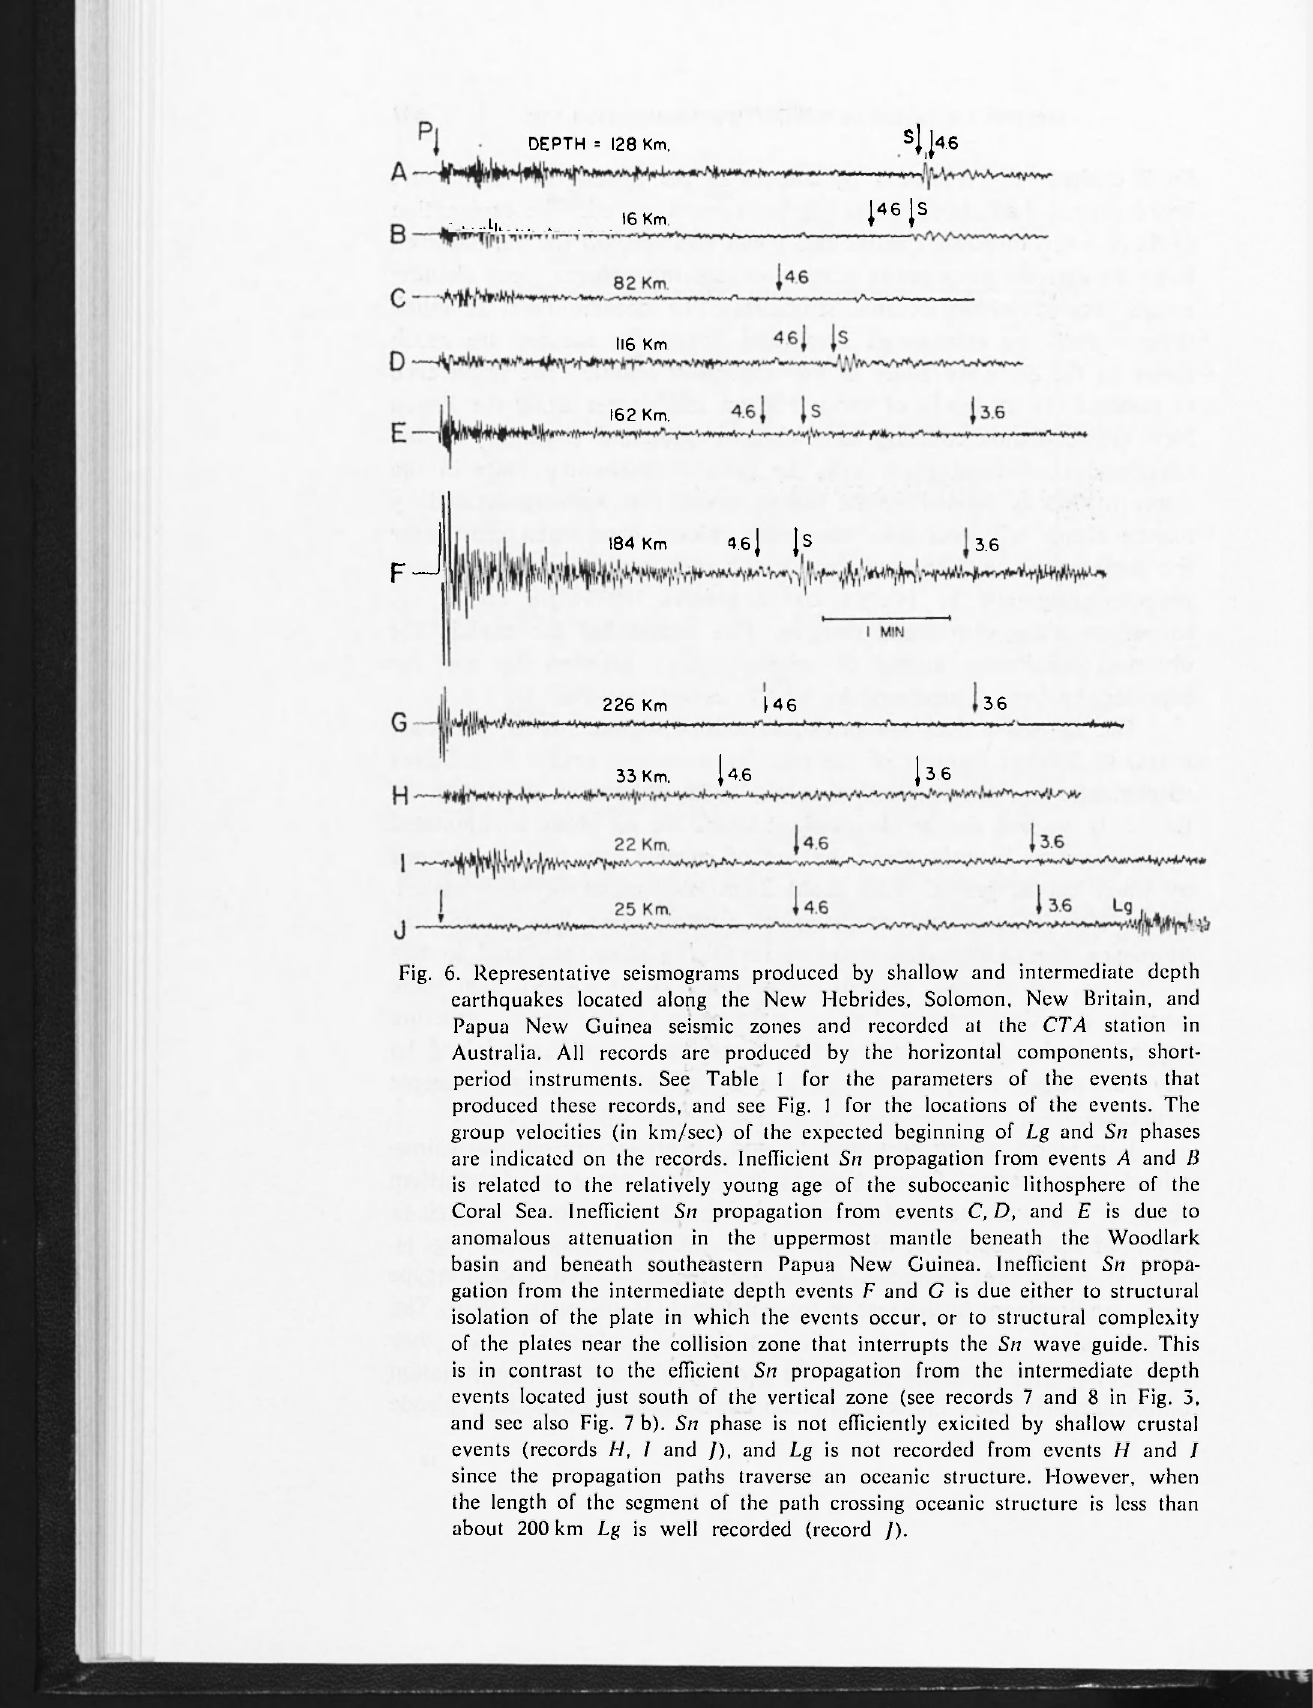
Fig. 6. Representative seismograms produced by shallow and intermediate depth earthquakes located along the New Hebrides, Solomon, New Britain, and Papua New Guinea seismic zones and recorded at the CTA station in Australia. All records are produced by the horizontal components, short- period instruments. See Table 1 for the parameters of the events that produced these records, and see Fig. 1 for the locations of the events. The group velocities (in km/sec) of the expected beginning of Lg and Sn phases are indicated on the records. Inefficient Sn propagation from events A and B is related to the relatively young age of the suboccanic lithosphere of the Coral Sea. Inefficient Sn propagation from events C,D, and E is due to anomalous attenuation in the uppermost mantle beneath the Woodlark basin and beneath southeastern Papua New Guinea. Inefficient Sn propa- gation from the intermediate depth events F and G is due either to structural isolation of the plate in which the events occur, or to structural complexity of the plates near the collision zone that interrupts the Sn wave guide. This is in contrast to the efficient Sn propagation from the intermediate depth events located just south of the vertical zone (see records 7 and 8 in Fig. 3, and sec also Fig. 7 b). Sn phase is not efficiently exicited by shallow crustal events (records H, I and /), and Lg is not recorded from events H and / since the propagation paths traverse an oceanic structure. However, when the length of the segment of the path crossing oceanic structure is less than about 200 km Lg is well recorded (record